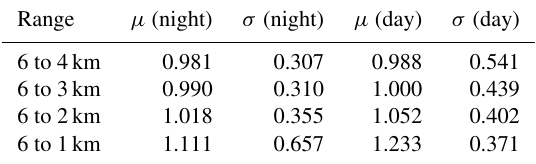
Table 4. Means ( µ ) and standard deviations ( σ ) of the ratios of inte- grated attenuated backscatters (CALIOP / HSRL) for 101 HSRL un- derflights of CALIPSO. Details about flight locations and dates can be found in Rogers et al. (2011) (day and night), Kar et al., (2018) (nighttime only), and Getzewich et al., (2018) (daytime